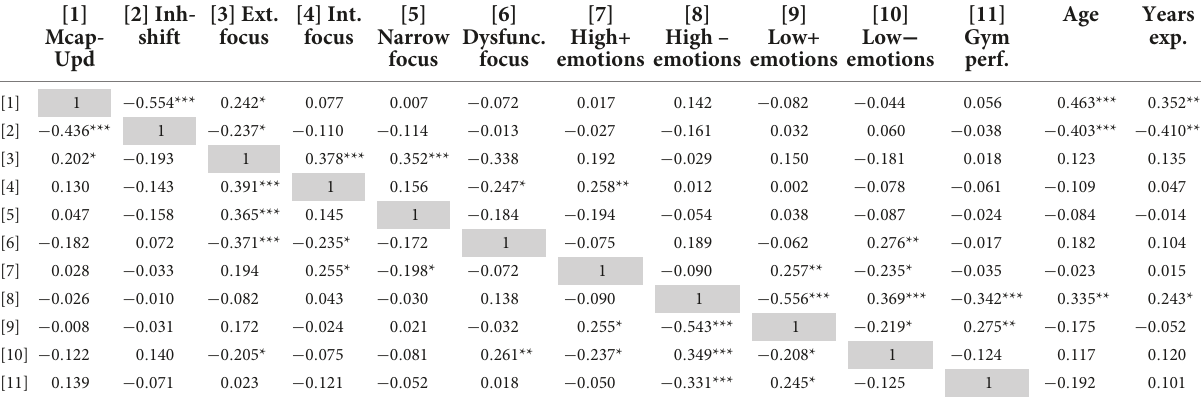
TABLE 7 Zero-order and partial correlations between predictors and the artistic gymnasts’